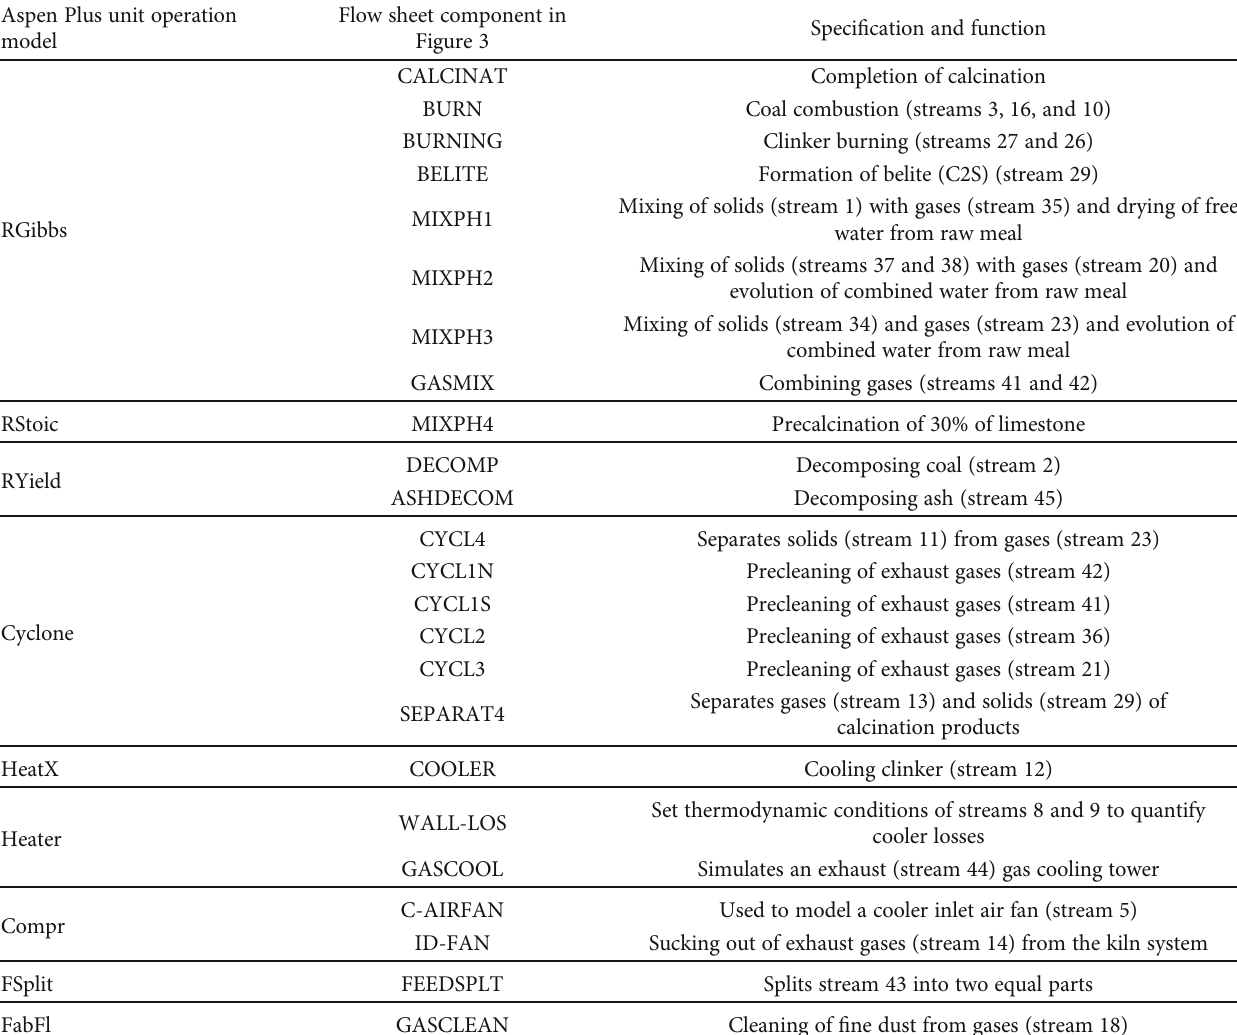
Table 1: Aspen Plus unit operation models in